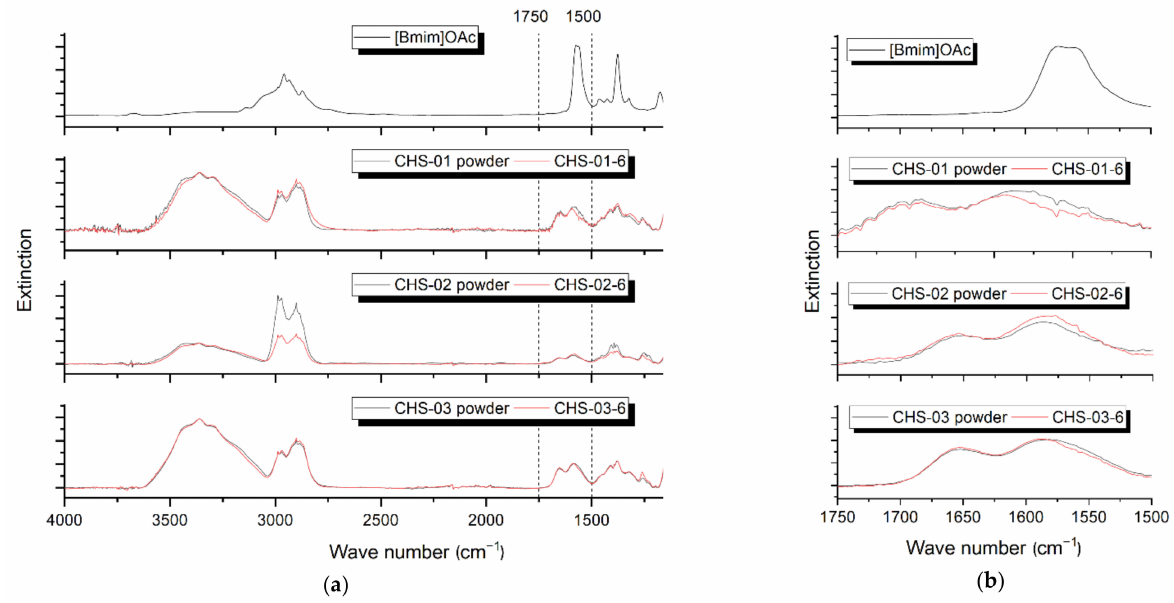
Figure 3. ( a ) FT-IR spectra of the ionic liquid BmimOAc, chitosan powders (CHS-01, CHS-02, CHS- 03) and fibers made from the powders with BmimOAc as solvent (CHS-01-6, CHS-02-6, CHS-03-6 with 6 wt.%); ( b ) section of the wave number range of 1600–1550 cm − 1